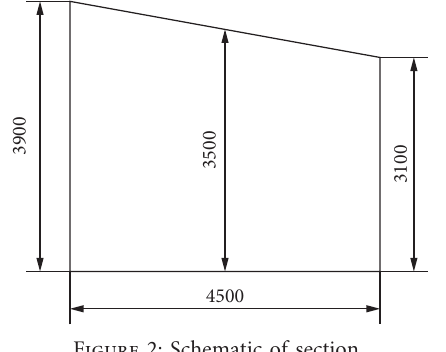
Figure 2: Schematic of section.